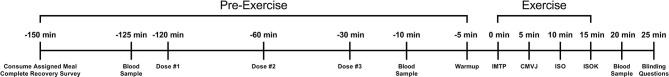
Experimental design. CMVJ, Counter-movement vertical jump; IMTP, Isometric mid-thigh pull; ISO, Isometric knee extensor assessment; ISOK, Isokinetic knee extensor assessment; Min, minutes.